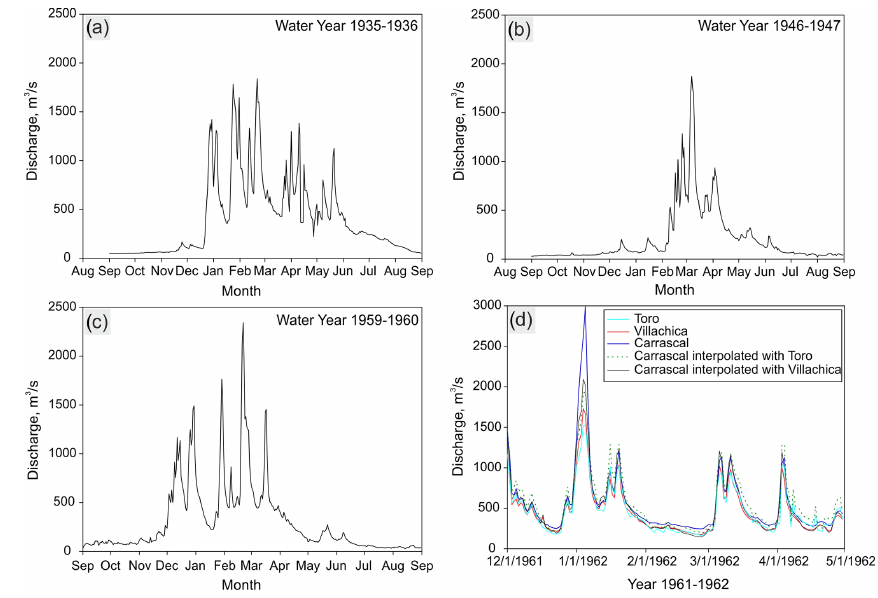
Figure 8. Daily discharges showing multiple peaks during selected water years: (a) 1935–1936, (b) 1946–1947, (c) 1959–1960. (c) Daily discharge recorded at the Villachica, Toro and Carrascal stations (see location in Fig. 1c). The recorded peak on 5 January 1962 in Carrascal was anomalously higher compared to Villachica and Toro records, and the peak was corrected using a linear regression.